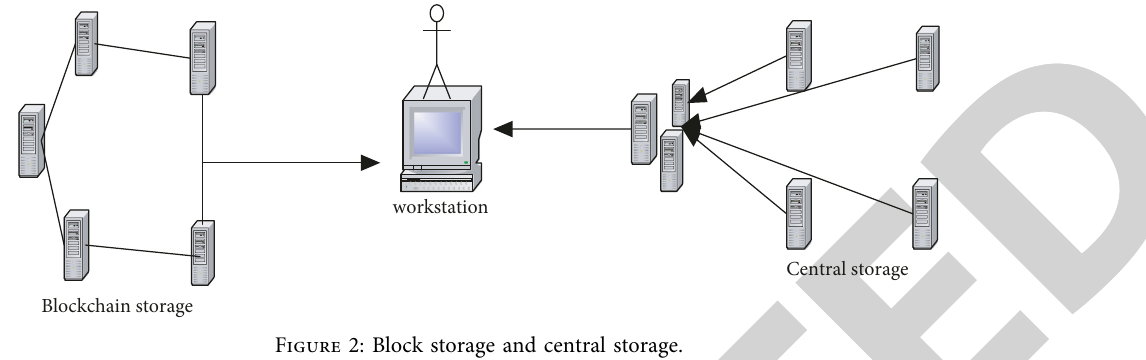
Figure 2: Block storage and central